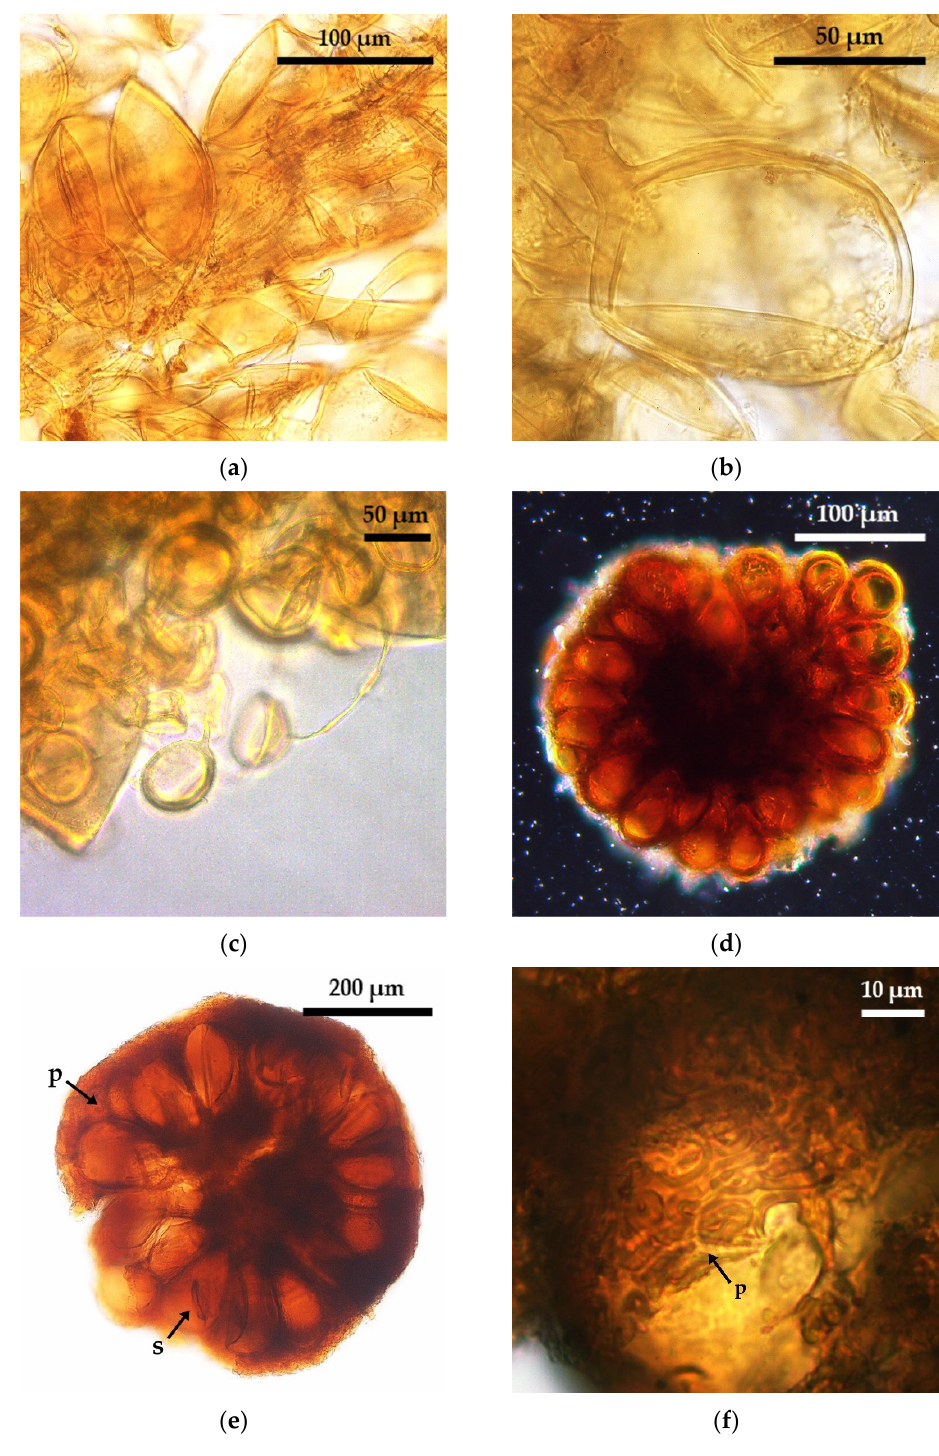
Figure 2. Glomoid AMF with spores in clusters and sporocarps. ( a ) Rhizoglomus aggregatus spore cluster in senescent root; ( b ) R. aggregatus spore with endospore; ( c ) R. microaggregatum spores inside other AMF spore; ( d ) Sclerocystis sp., general view of the spores without peridium; ( e ) S. sinuosa , general view of the spores (s) with peridium (p); ( f ) S. sinuosa , detail of the hyphal peridium (p).